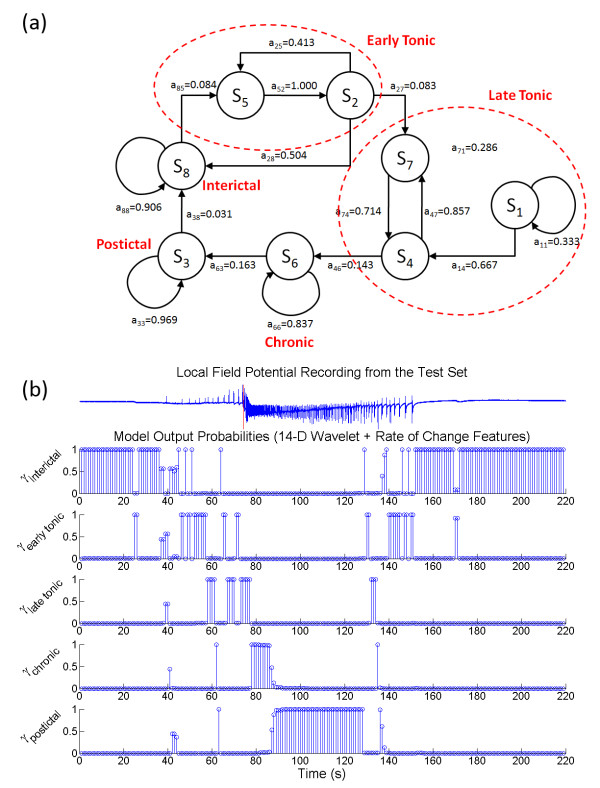
The transition diagram and the posterior probabilities for HMMopt14D using the original feature space. (a) The state transition diagram for HMMopt14D is given along with a sample LFP recording. For an eight state model, some of the states represent the same electrophysiological dynamics and hence can be consolidated. The HMM states S1, S4 and S7 represent the late tonic activities. They are interconnected and are always followed by the chronic activity and preceded by early tonic firing states S2 and S5. The early tonic activity of this HMM is also allowed to return to interictal state without generating seizures. (b) The mapping of HMMopt14D to the electrophysiological events is provided. Typically, this model is able to differentiate early and late tonic firing. For this particular example, the model output switches between interictal and early tonic state until about 46 s.